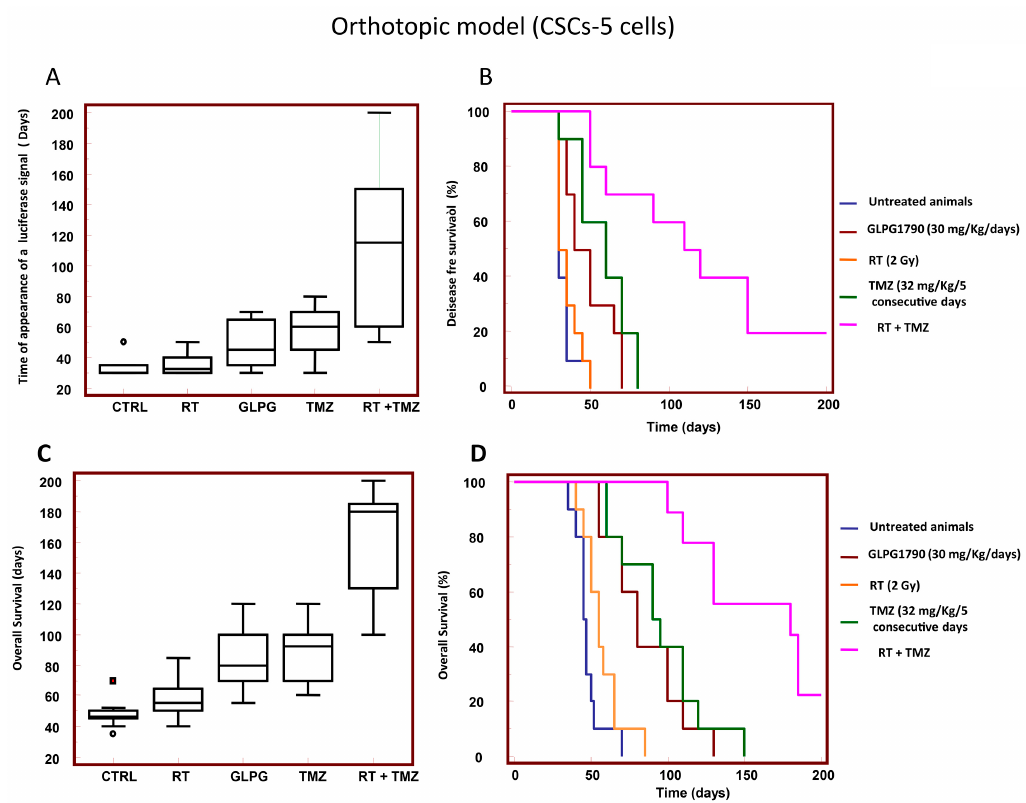
Figure 8. GLPG1790 increases DFS and OS in orthotopic intra-brain tumours using differentiated patient derived GICs (GSCs-5). GICs were inoculated into the brain and treated as indicated in Figure 7.